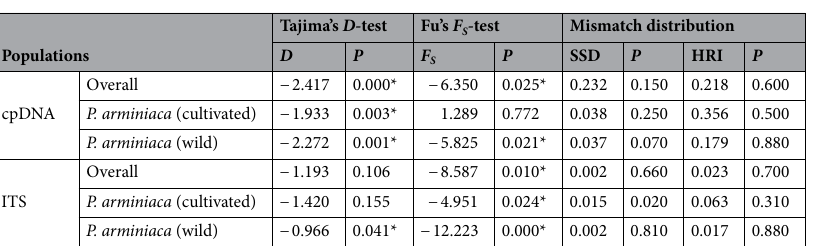
Table 5. Neutrality tests (Tajima’s D and Fu’s F S ) and mismatch distribution analysis for the P. armeniaca based on the cpDNA and ITS dataset. * P < 0.05.